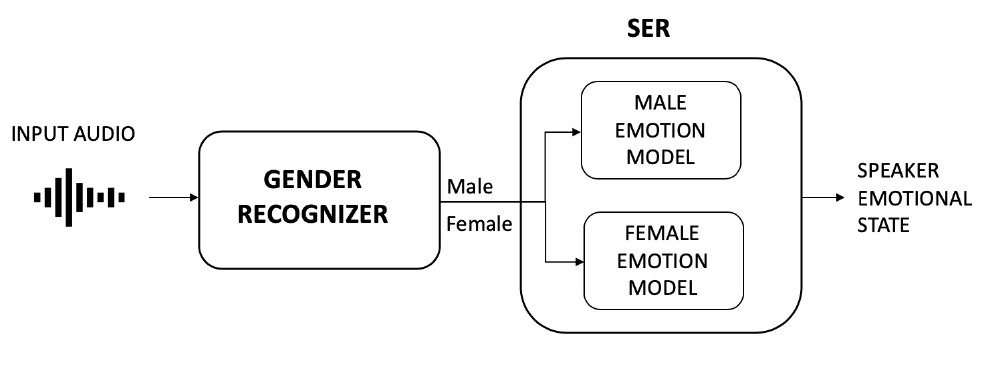
Figure 1. Example of a two-level recognizer architecture for Speech Emotion Recognition